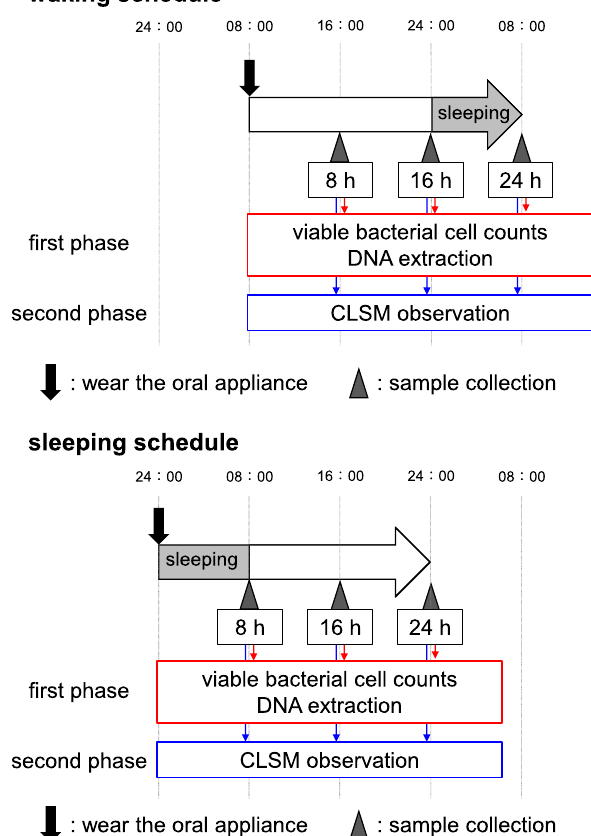
Figure 2. Schedule and sample collection timings. Schematic of the schedule and sample collection timings. Subjects began wearing the oral appliances (indicated by a black arrow) at 8:00 for the waking schedule and at 24:00 for the sleeping schedule. Biofilm samples were collected after wearing the oral appliances for 8 h, 16 h, or 24 h, as indicated by arrowheads. In both the waking and sleeping schedules, the subjects wore the oral appliances for 24 h and slept from 24:00 to 8:00. In the first phase, disks were collected for use in viable bacterial cell counts and DNA extraction (for real-time PCR and 16S rRNA sequence analysis). In the second phase, disks were collected at each sample collection timepoint for confocal laser scanning microscopy (CLSM)